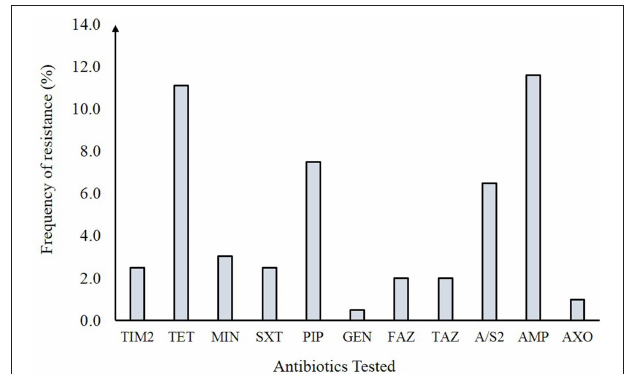
FIGURE 2 | Antibiotic resistance frequencies in 198 non-typhoidal Salmonella (NTS) isolates from Michigan. TIM2, Ticarcillin / clavulanic acid constant